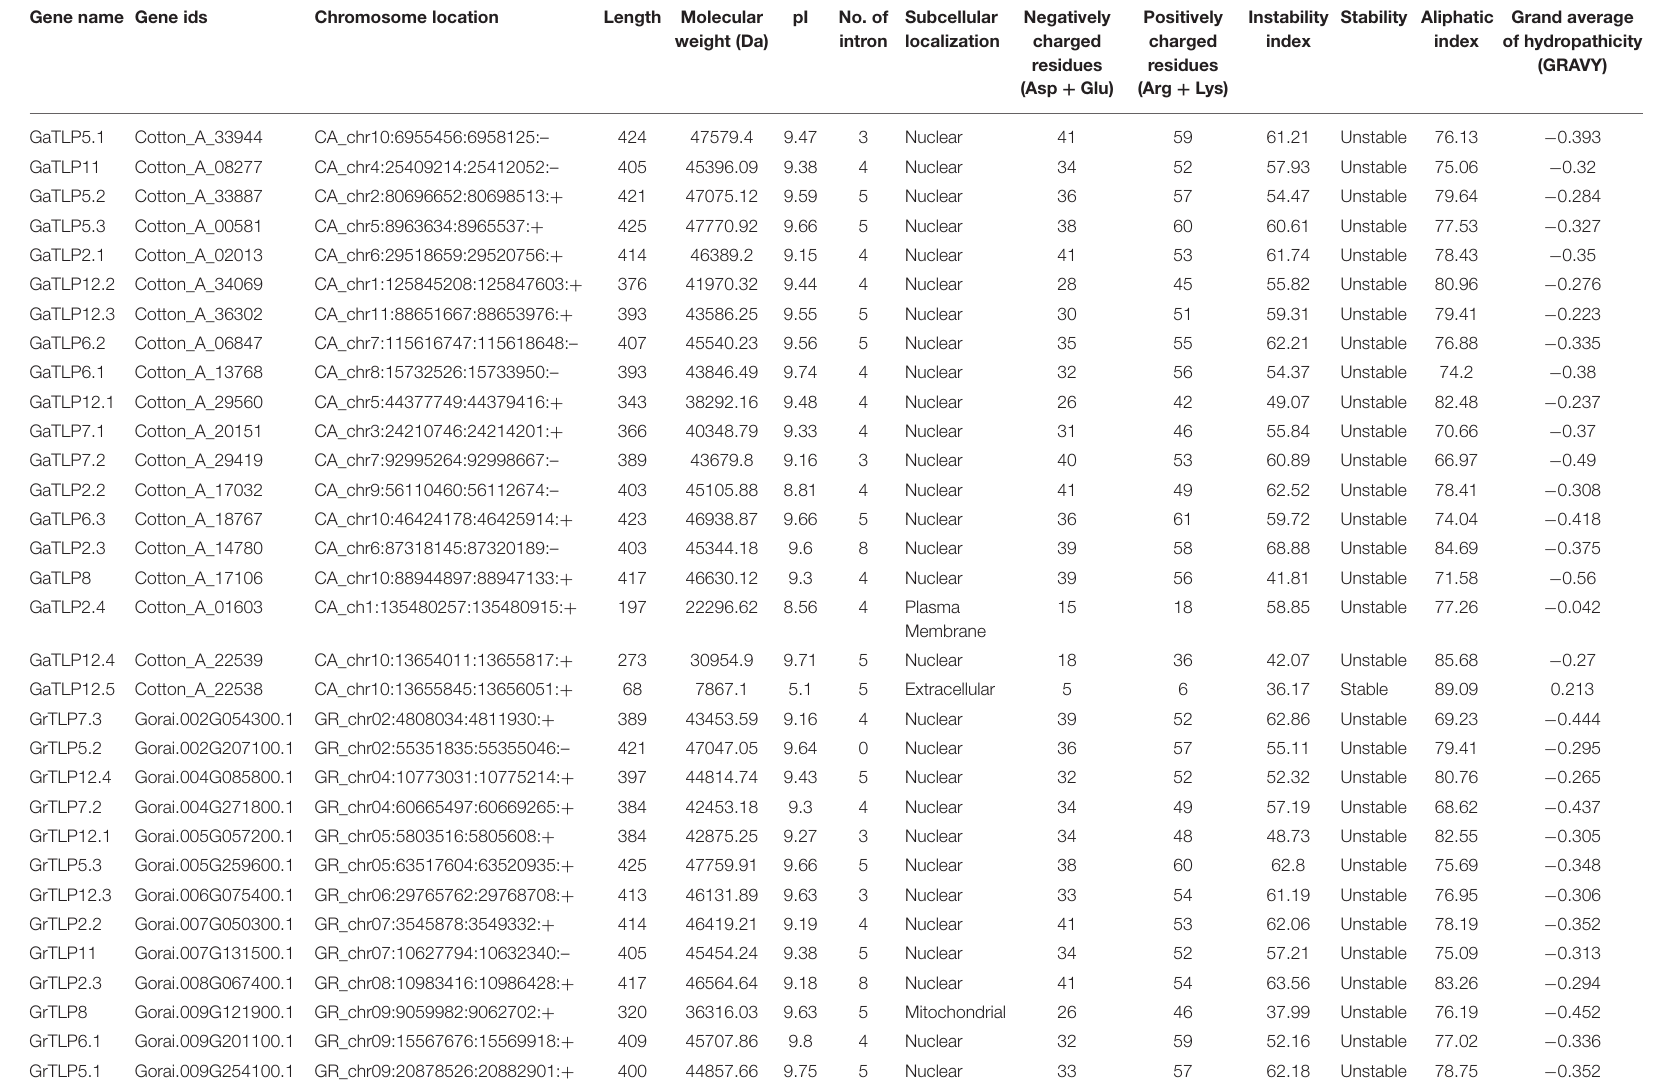
TABLE 1 | Characteristics of TLP genes in